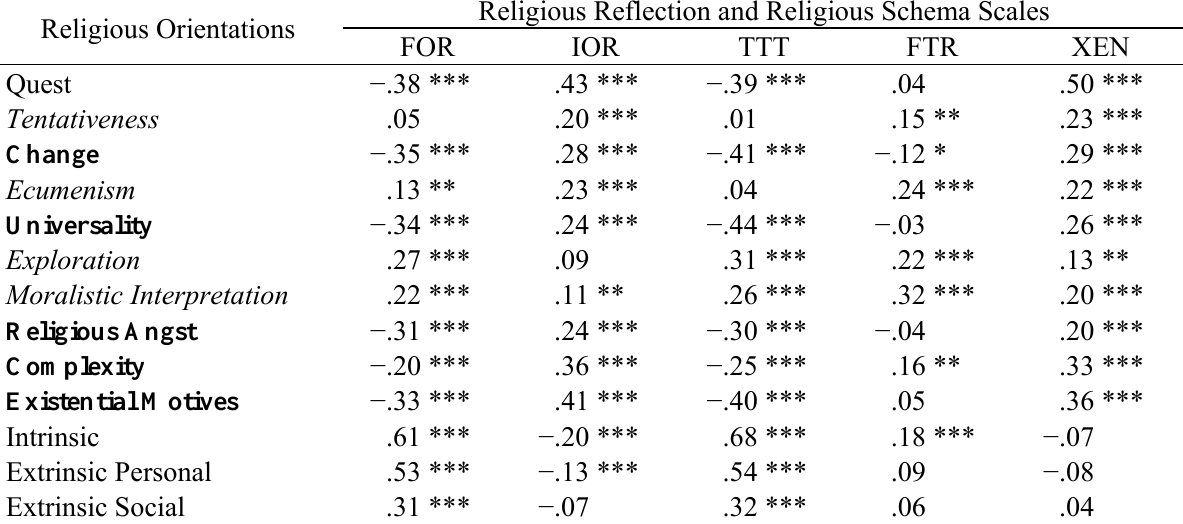
Table 2. Correlations of Religious Reflection and Religious Schema Scales with Quest and Religious Orientation Measure